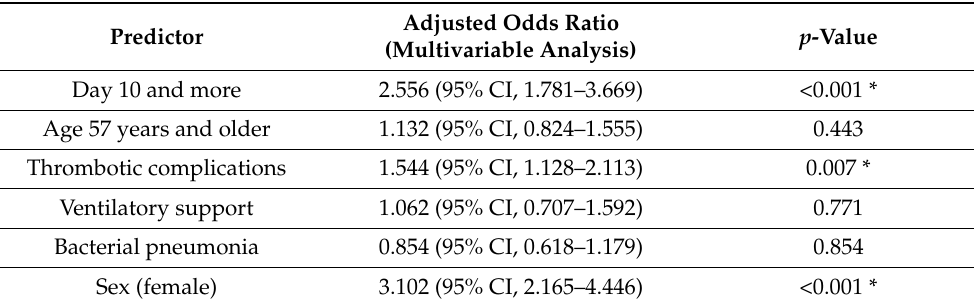
Table 6. Results of multivariable regression analysis: independent predictors of increased mean optical density (above 0.50) in venous endothelium (with adjusted odds ratio calculation).